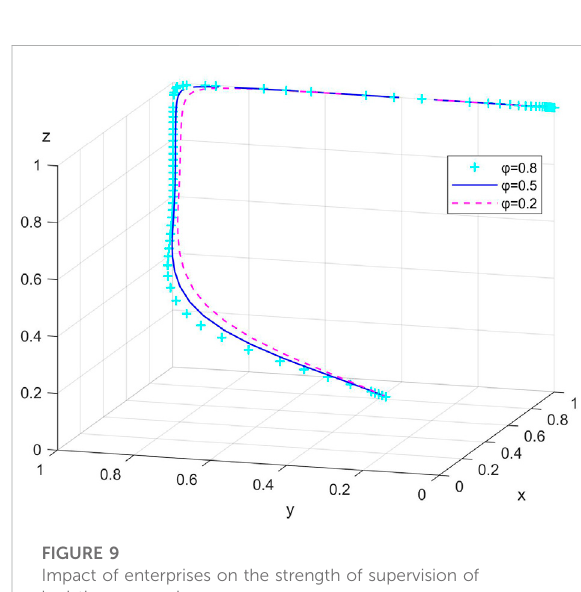
FIGURE 9 Impact of enterprises on the strength of supervision of logistics